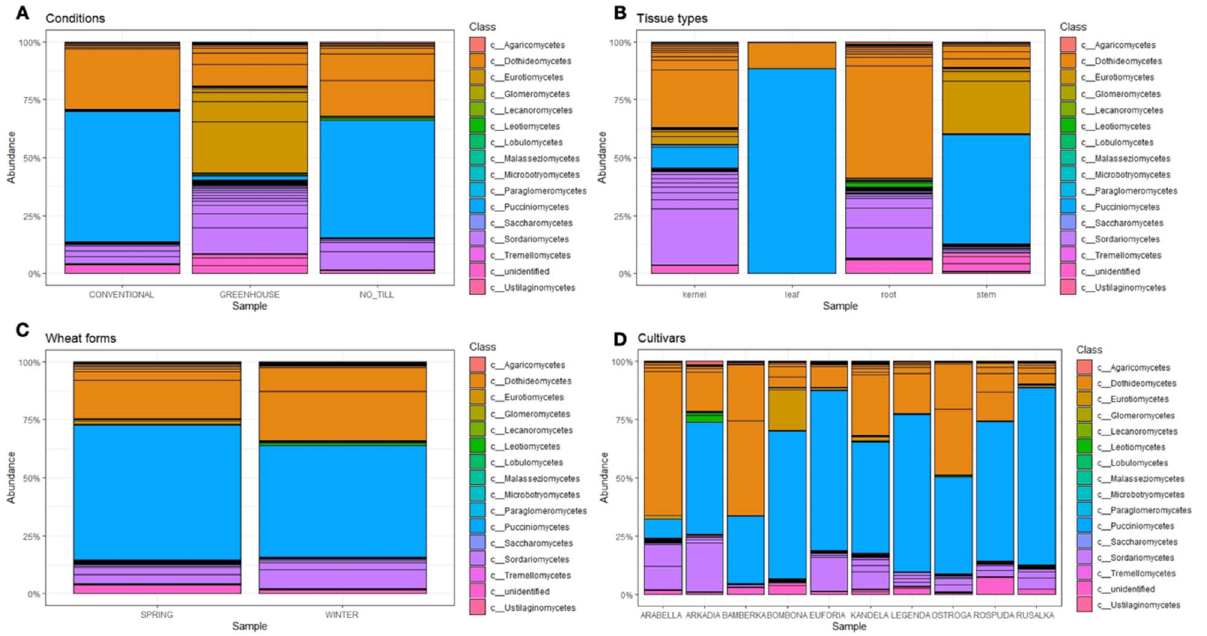
Figure 5. Relative abundance of endogenous fungi of wheat from diverse ( A ) conditions, ( B ) tissue types, ( C ) forms, and ( D ) cultivars on a class level.